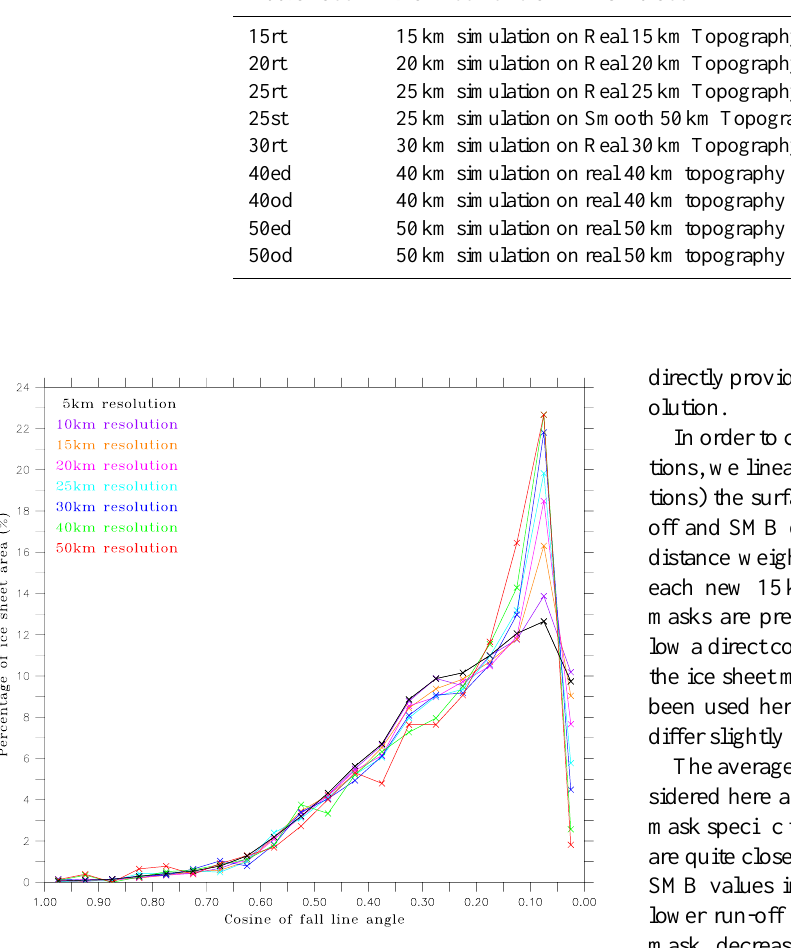
Fig. 2. Distribution (in percentage of the ice sheet area) of the cosine of fall line angle of the 5km ice sheet topography of Bamber et al. (2001a,b), interpolated at 10–50km